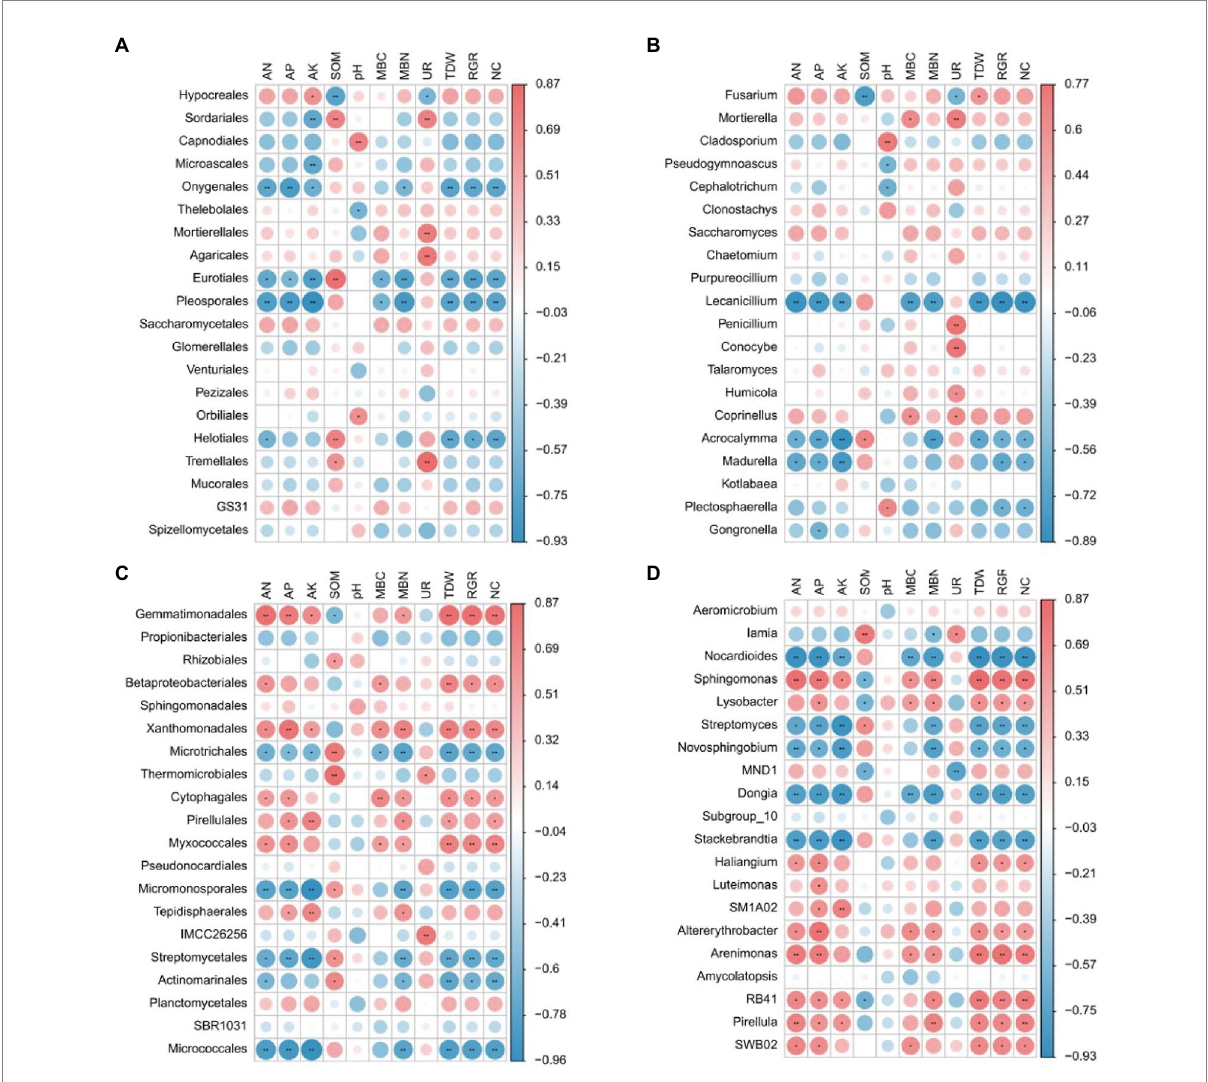
FIGURE 7 Spearman correlations between the relative abundance of microbial community [ (A) the dominant fungal order; (B) fungal genus; (C) bacterial order; (D) bacterial genus] and environmental factor (edaphic indicator and plant indicator). The red color indicates positive correlations, while the blue color indicates negative correlations (* p < 0.05, ** p < 0.01;